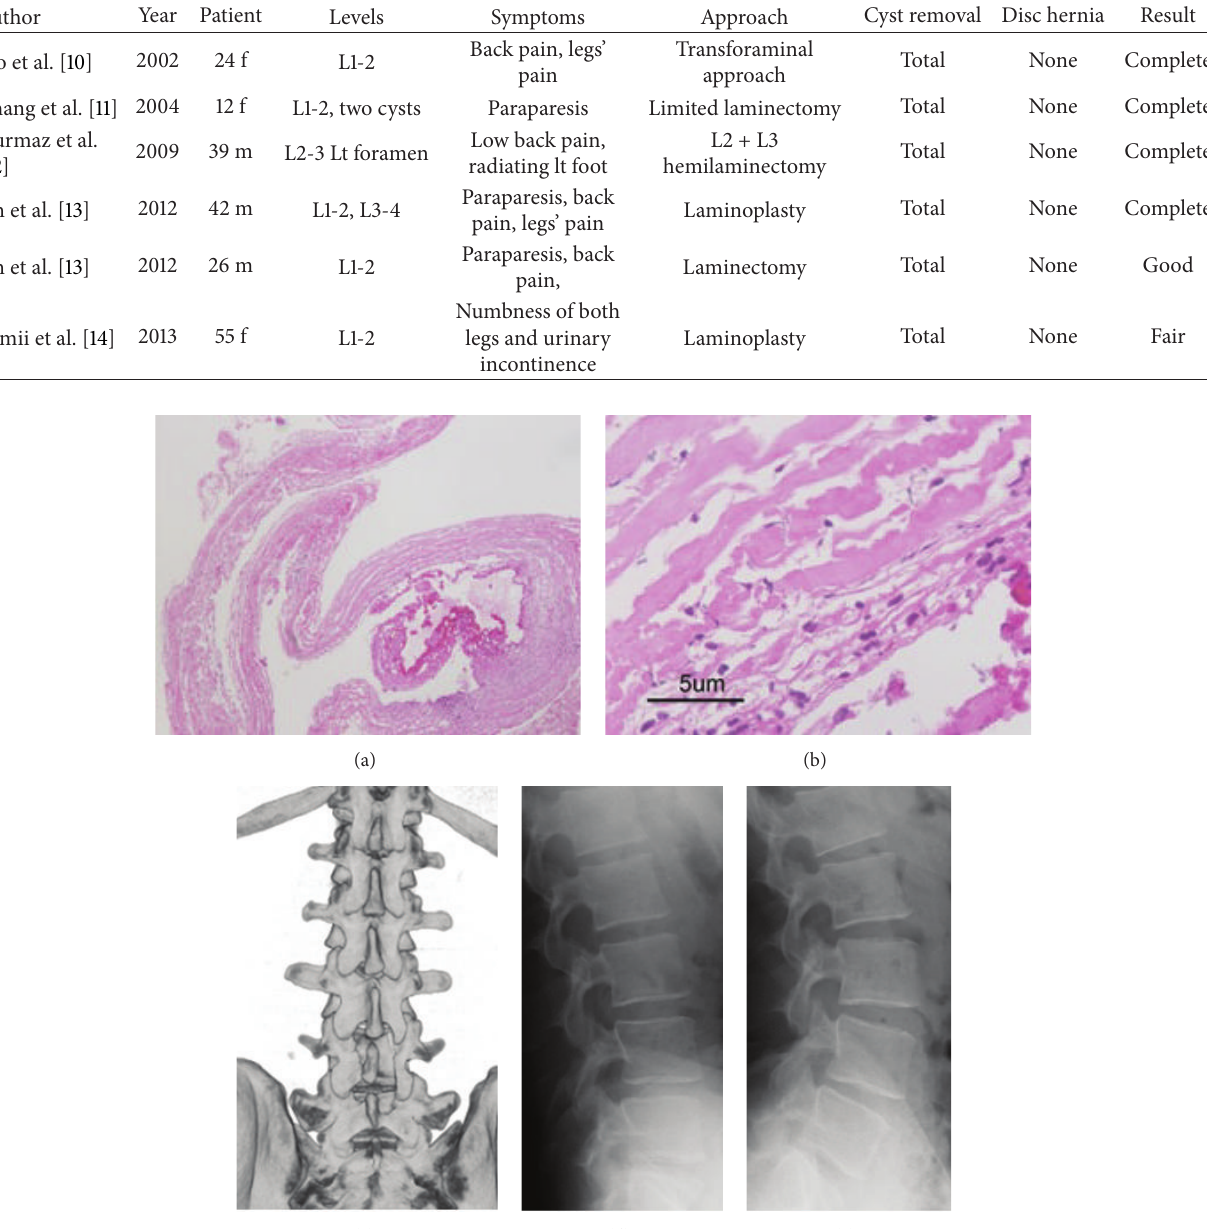
Table 1: Summary of published reports of lumbar epidural arachnoid cysts (EACs). The clinical outcomes are categorized into 3 groups: complete, good, and fair.